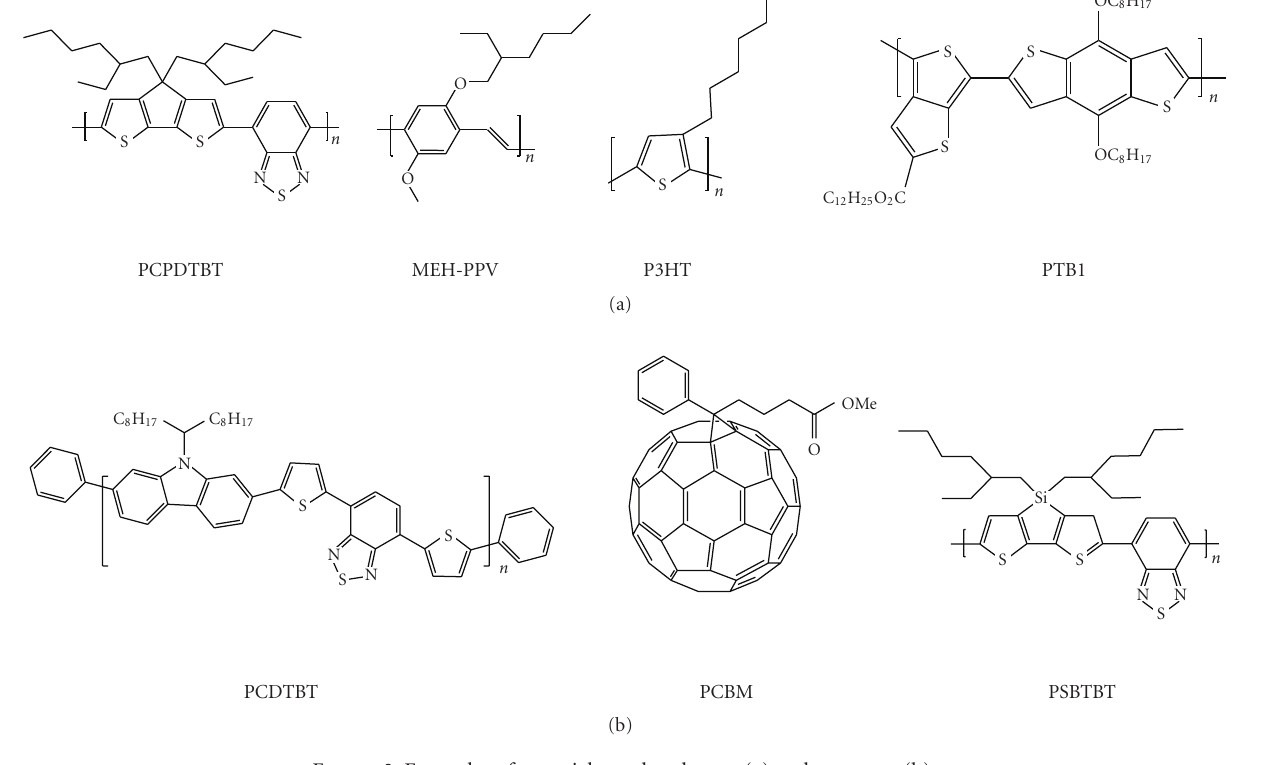
Figure 2: Examples of materials used as donors (a) and acceptors (b).